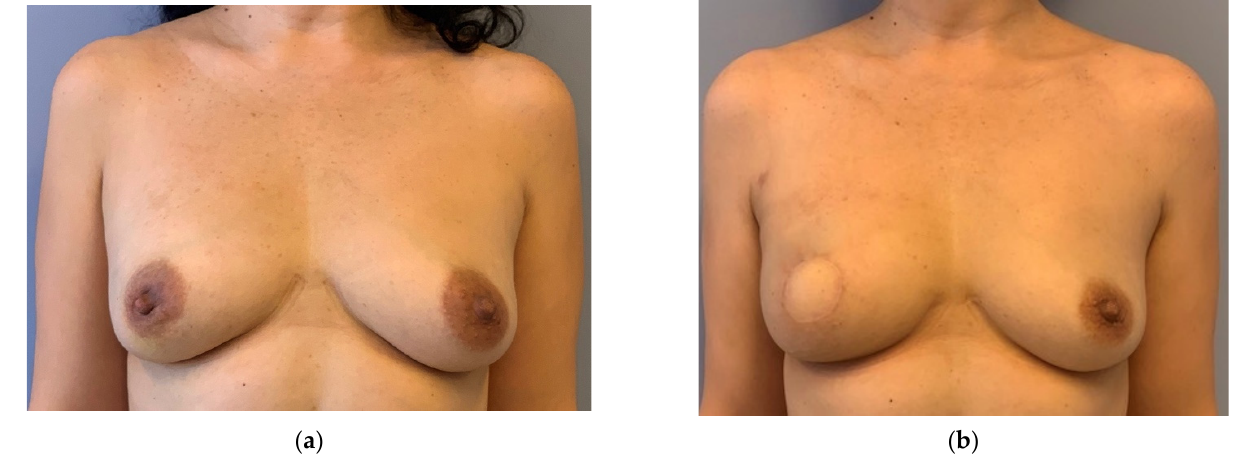
Figure 2. ( a ) Preoperative: 46 years old, otherwise healthy patient with invasive breast cancer on the right side. She underwent a skin-sparing mastectomy, sentinel-lymphonodectomy and immediate reconstruction with DIEP-flap (ERAS-group). ( b ) Postoperative: Patient seen 6 months after surgery and radiation therapy. The skin island replaces the areola. Operation time 157 min, ischemia time 42 min, 2.5 mm coupler, flap weight 420 g, length of stay 4 days.